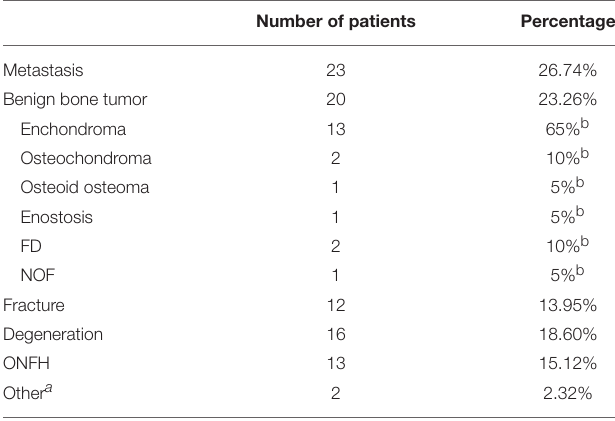
TABLE 2 | Bone disease types among 86